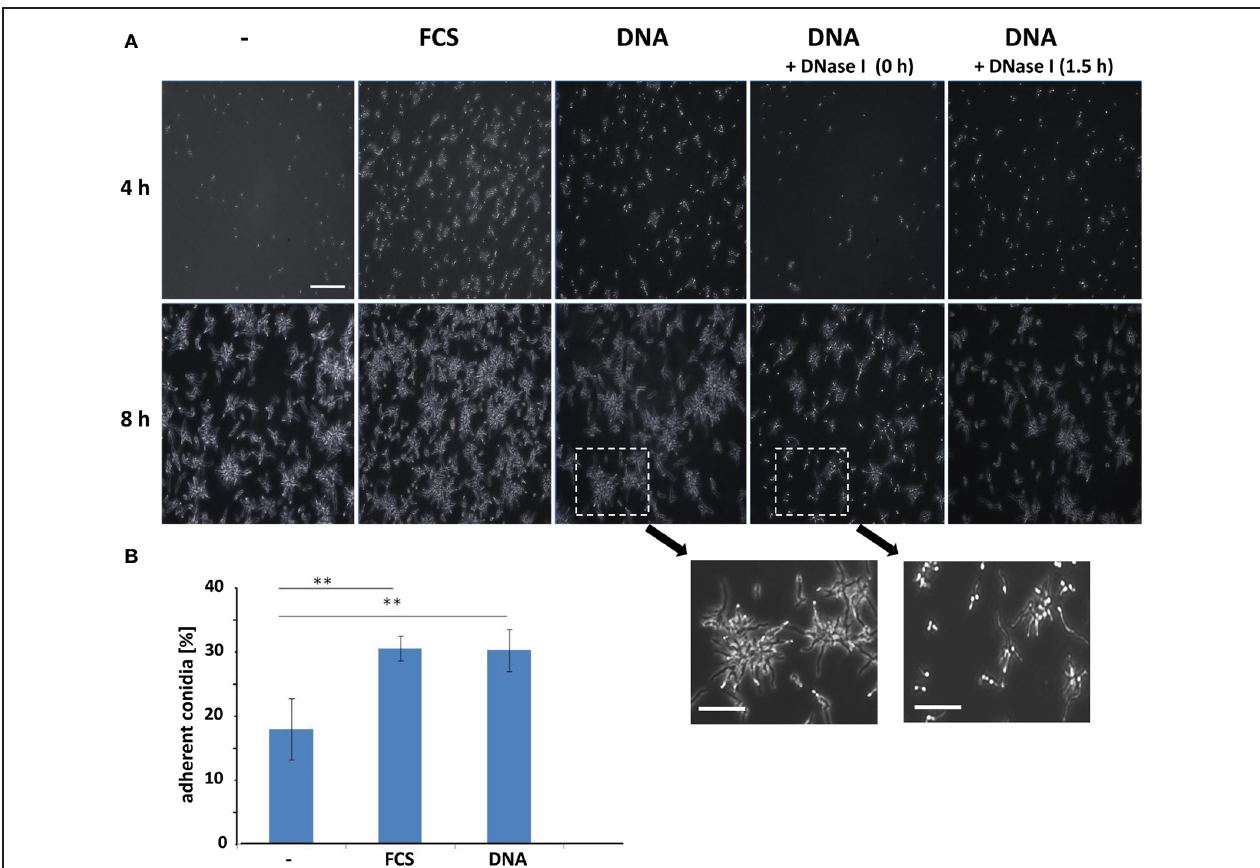
FIGURE 3 | Conidial surface adhesion is enhanced by extrinsic DNA. (A) Conidia at an initial concentration of 2 × 10 6 per well in RPMI were allowed to adhere to polystyrene surfaces in the presence of FCS or sheared DNA (sDNA) as additives. DNase I was added at indicated time points during the 4h adhesion phase. After washing microscopy images were either taken directly following the adhesion phase (4h,